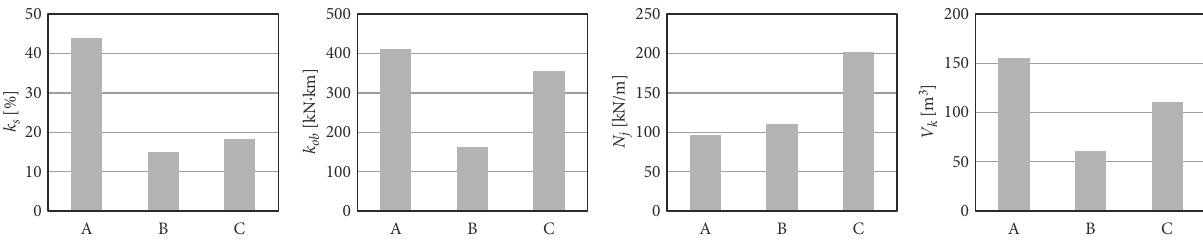
Figure 3. Compacted surface k s , field loading k ob , loading in a rut N j and ruts volume V k for three machine aggregates in farms A, B and C